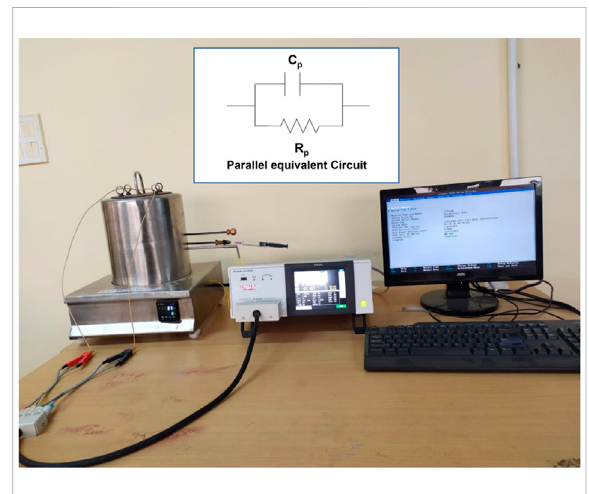
FIGURE 11 Schematic of a dielectric setup including an equivalent circuit, a furnace, a gas-sensing system, and a LCR meter (parallel equivalent circuit is shown in the